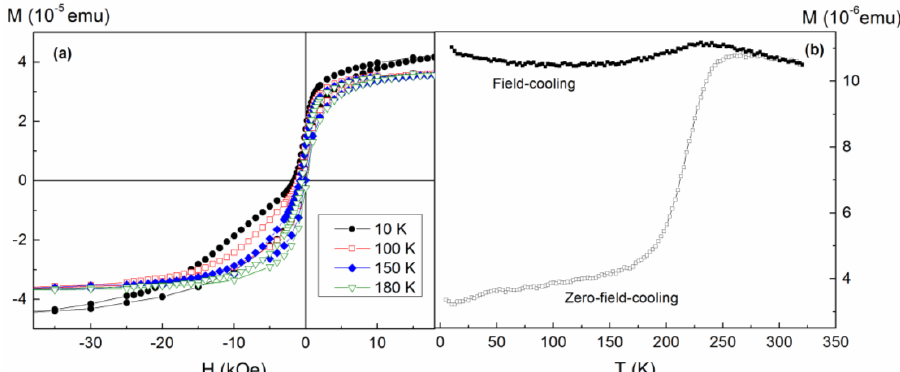
Figure 4. ( a ) Hysteresis loops of the sample annealed for 456 h recorded at different temperatures after field-cooling from 300 K (only the data over a limited H range are presented) and ( b ) zero-field-cooled and field-cooled magnetization curves measured in the same sample in an applied field of 500 Oe.